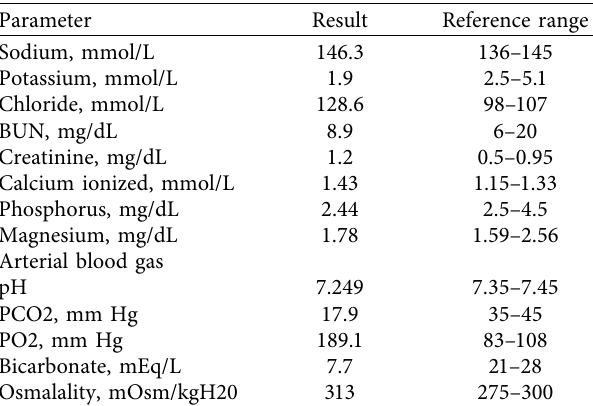
Table 1: Laboratory findings on admission.